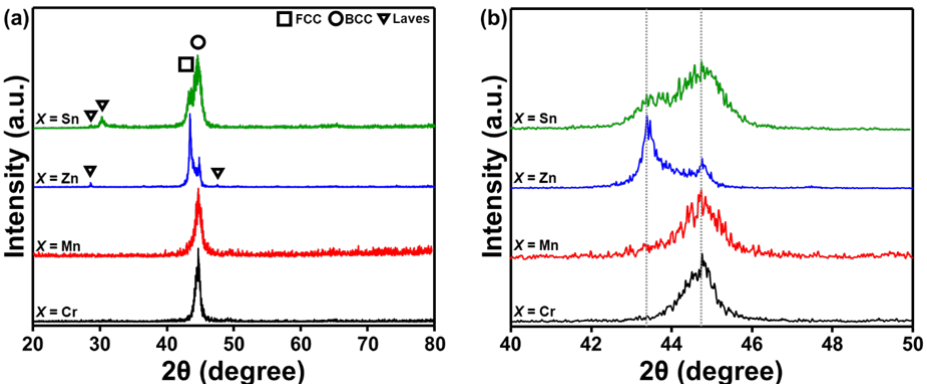
Figure 1. ( a ) XRD patterns of the HEBMed AlCuSiFeX (X = Cr, Mn, Zn, Sn) HEAs after 45 h and ( b ) the magnified major peak of ( a ).